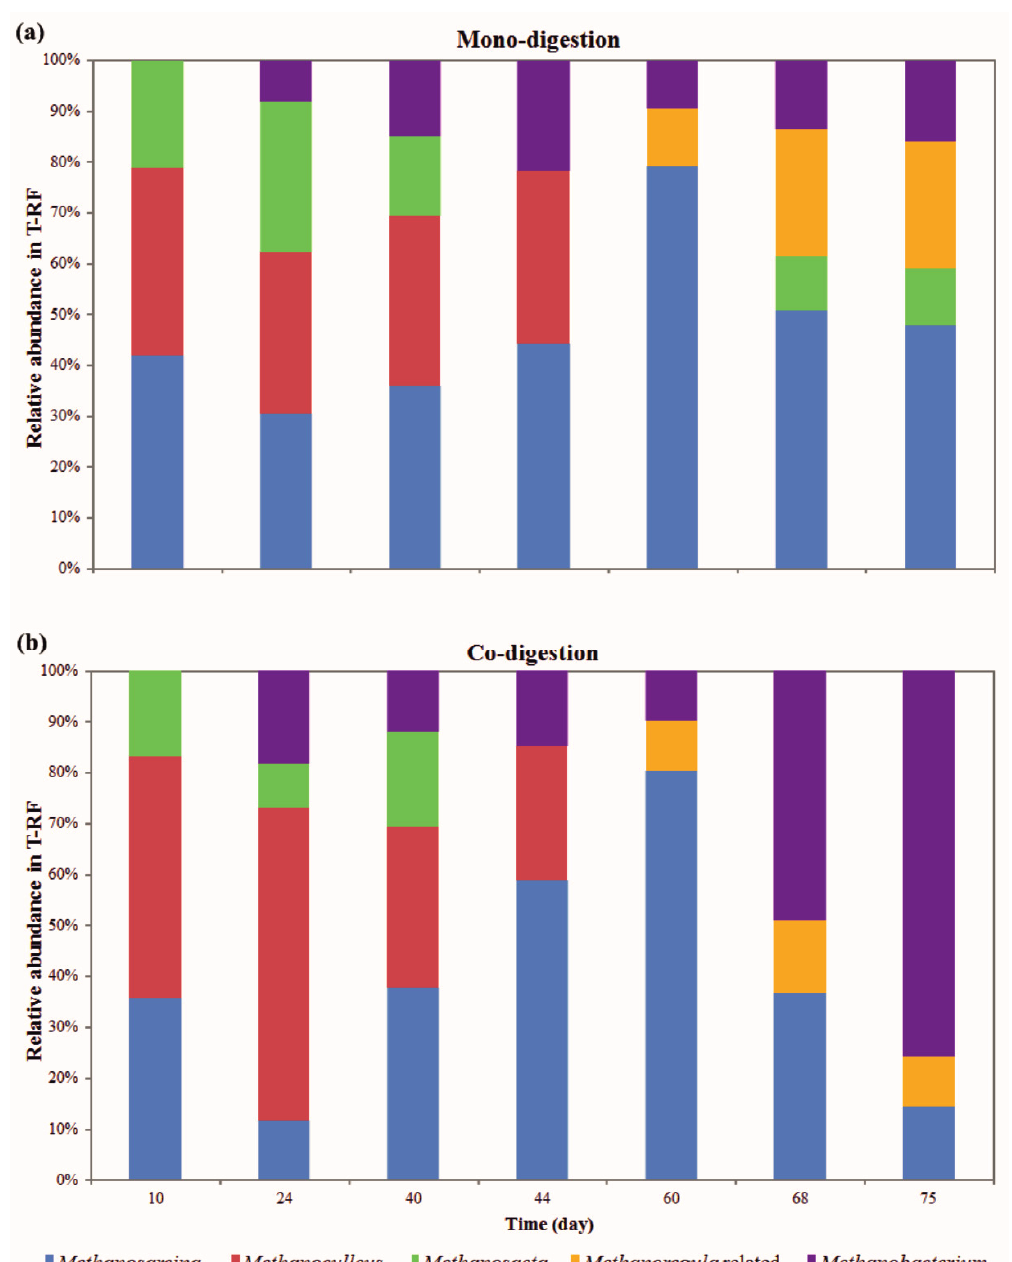
Figure 1. Methanogenic community dynamics in the mono- ( a ) and co-digestion ( b ) reactor. The relative T-RF abundance of methanogens in the digestate samples are given as function of experiment time. For each of the parallel reactors in the specific digestion set-up, two samples were analyzed, that in total four samples were analyzed for each, mono- and co-digestion. All samples belonging to the same digestion set-up had similar methanogenic community based on the relative T-RF abundances. Therefore, each bar on the graphic represents the T-RFLP profile calculated by the average of the four analyzed samples in each digestion set-up. The supporting clone libraries and sequence analysis of the selected clones allowed the taxonomic affiliation of the T-RFs from the community T-RFLP profiles of the complex reactor